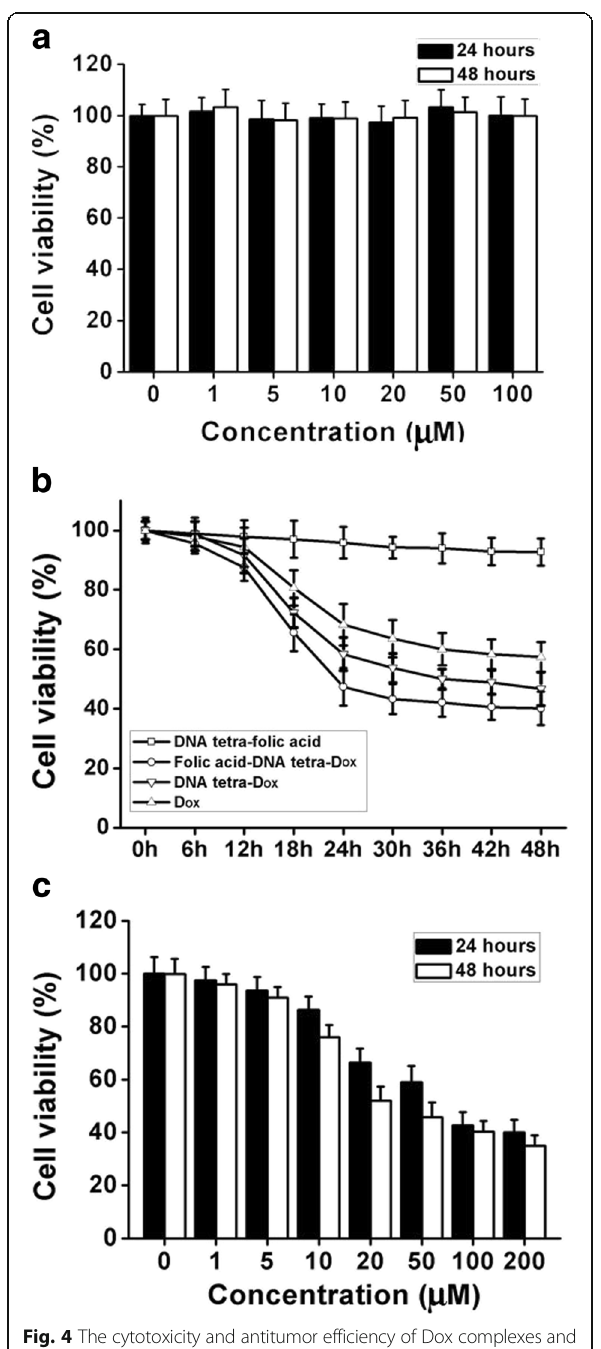
Fig. 4 The cytotoxicity and antitumor efficiency of Dox complexes and DNA tetra for HT-29 cells. a The viability of HT-29 cells incubated with DNA tetra at different concentrations for 24 or 48 h. b The antitumor efficiency of Dox complexes at 100 μ M. c The viability of HT-29 cells incubated with folic acid-DNA tetra-Dox at different concentrations for 24 or 48 h